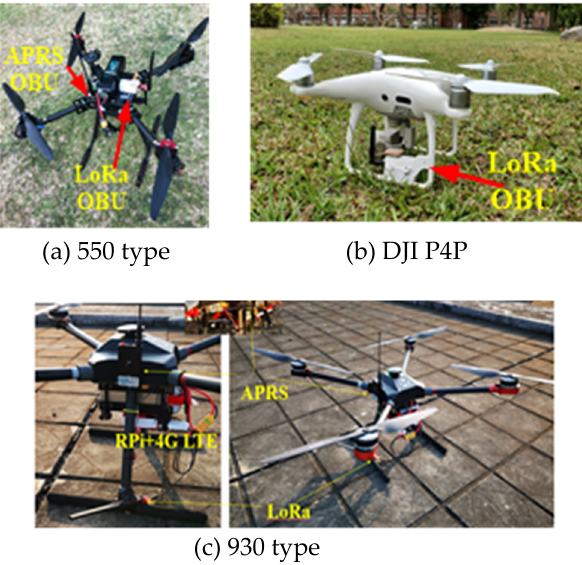
Figure 9. OBUs mounting on UAVs for flight tests.